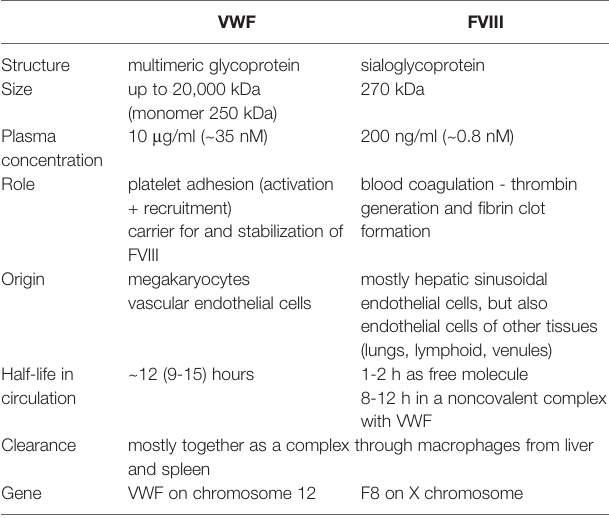
TABLE 1 | General information about VWF and FVIII (9,